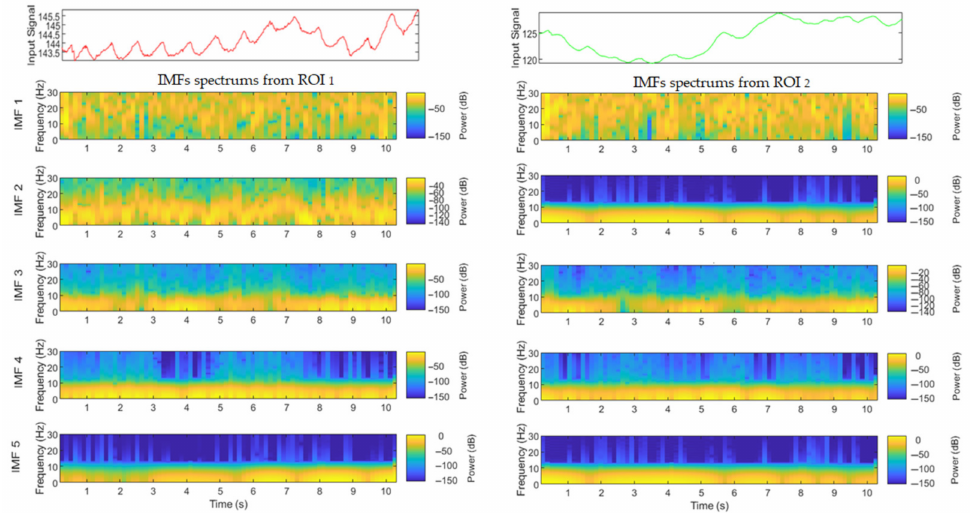
Figure 4. Signal decomposition of i G 1 ( t ) and i G 2 ( t ) using a decomposition method with 100 realizations and 100 iterations.